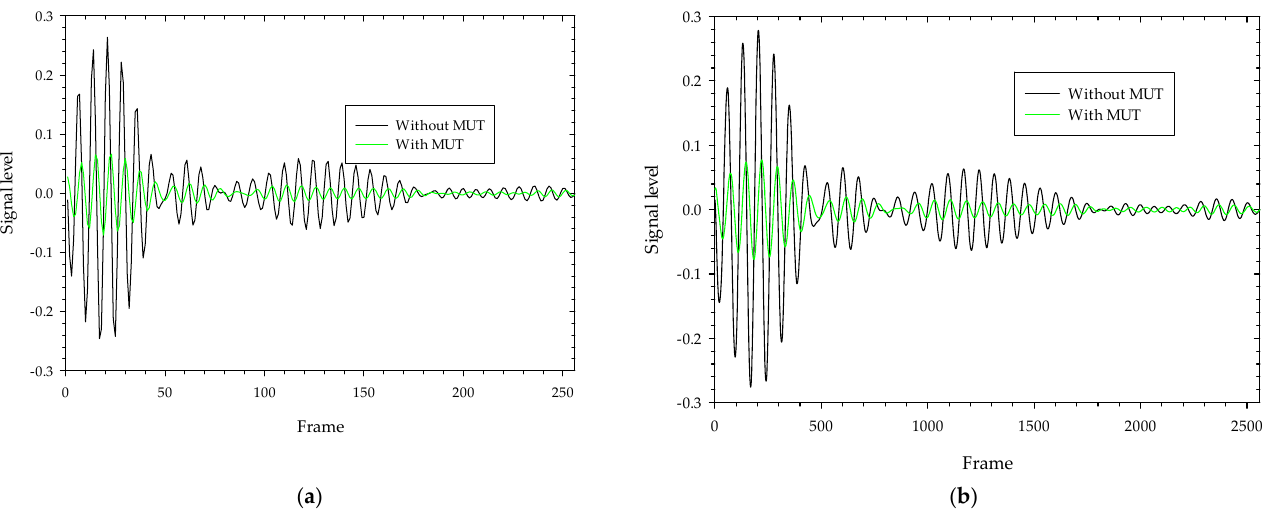
Figure 10. Correlated received pulse signals with and without MUT (ethanol) for PGSelect = 0; ( a ) correlated signals; ( b ) resample correlated signals.